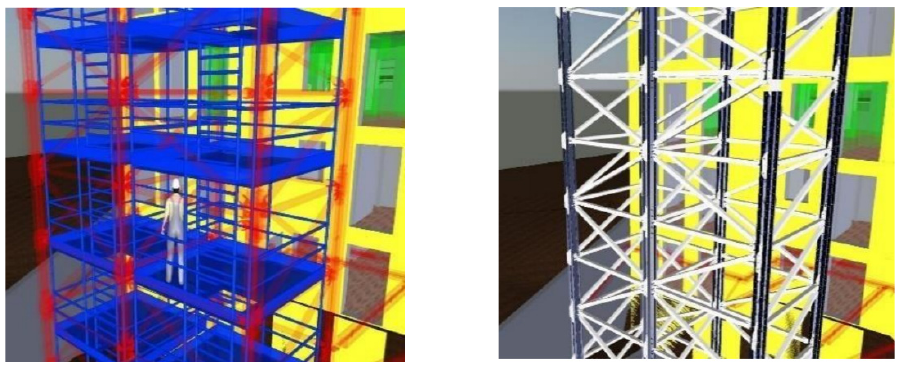
Figure 15. Clash test of temporary scaffolding and temporary support structure.